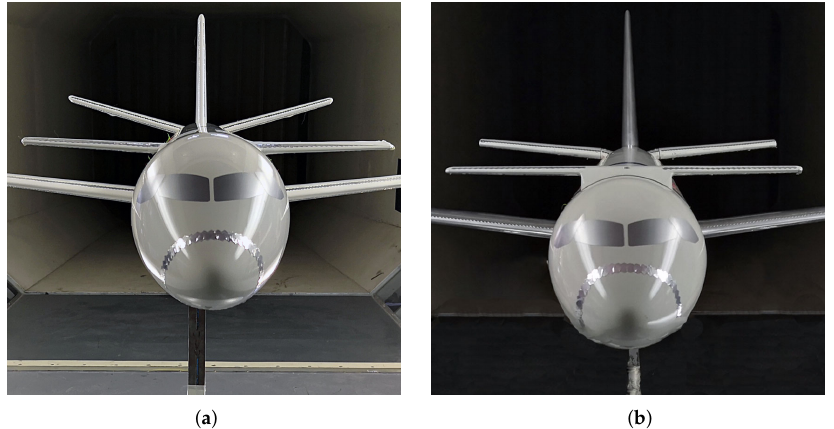
Figure 5. Change in canard position and horizontal tail dihedral. ( a ) Design Loop 1 front view;